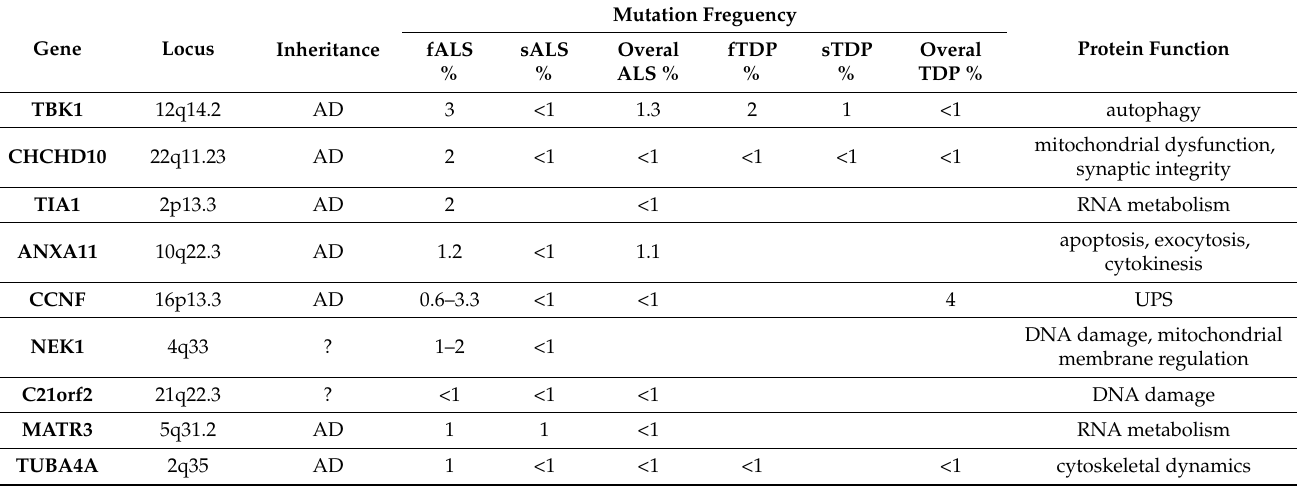
Table 1. Overview of recent ALS genes in different form ALS and